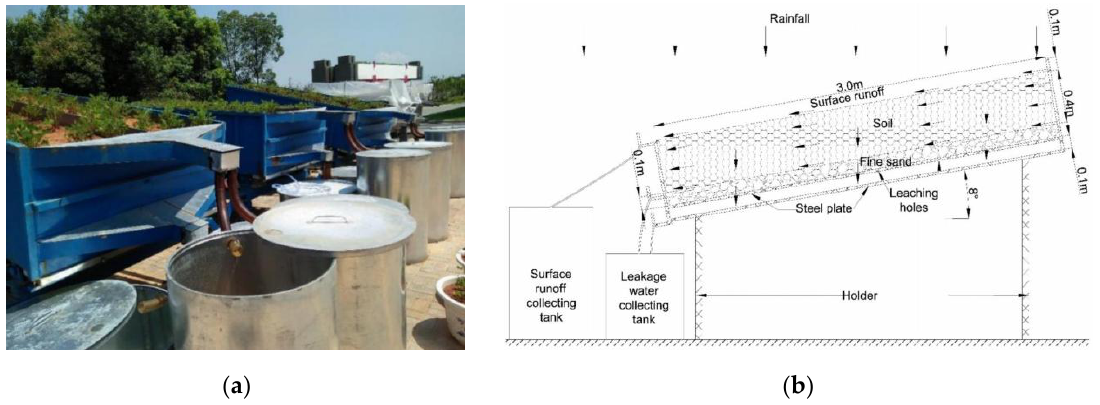
Figure 1. Test device diagram: ( a ) field diagram of lysimeter; ( b ) schematic of lysimeter [22].